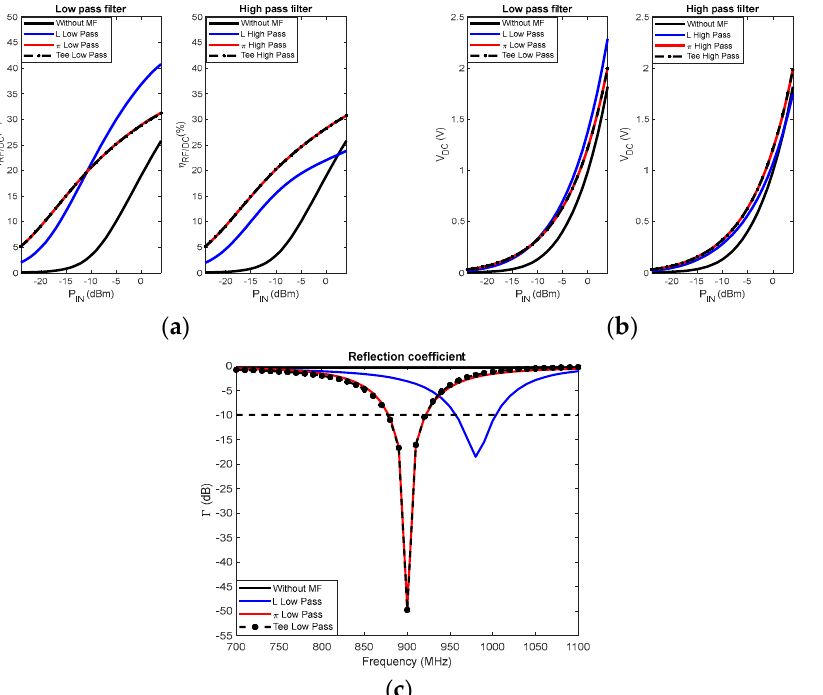
Figure 17. Comparison of performance achieved with various filter configurations. ( a ). Efficiency. ( b ) Voltage. ( c ) Reflection coefficient.